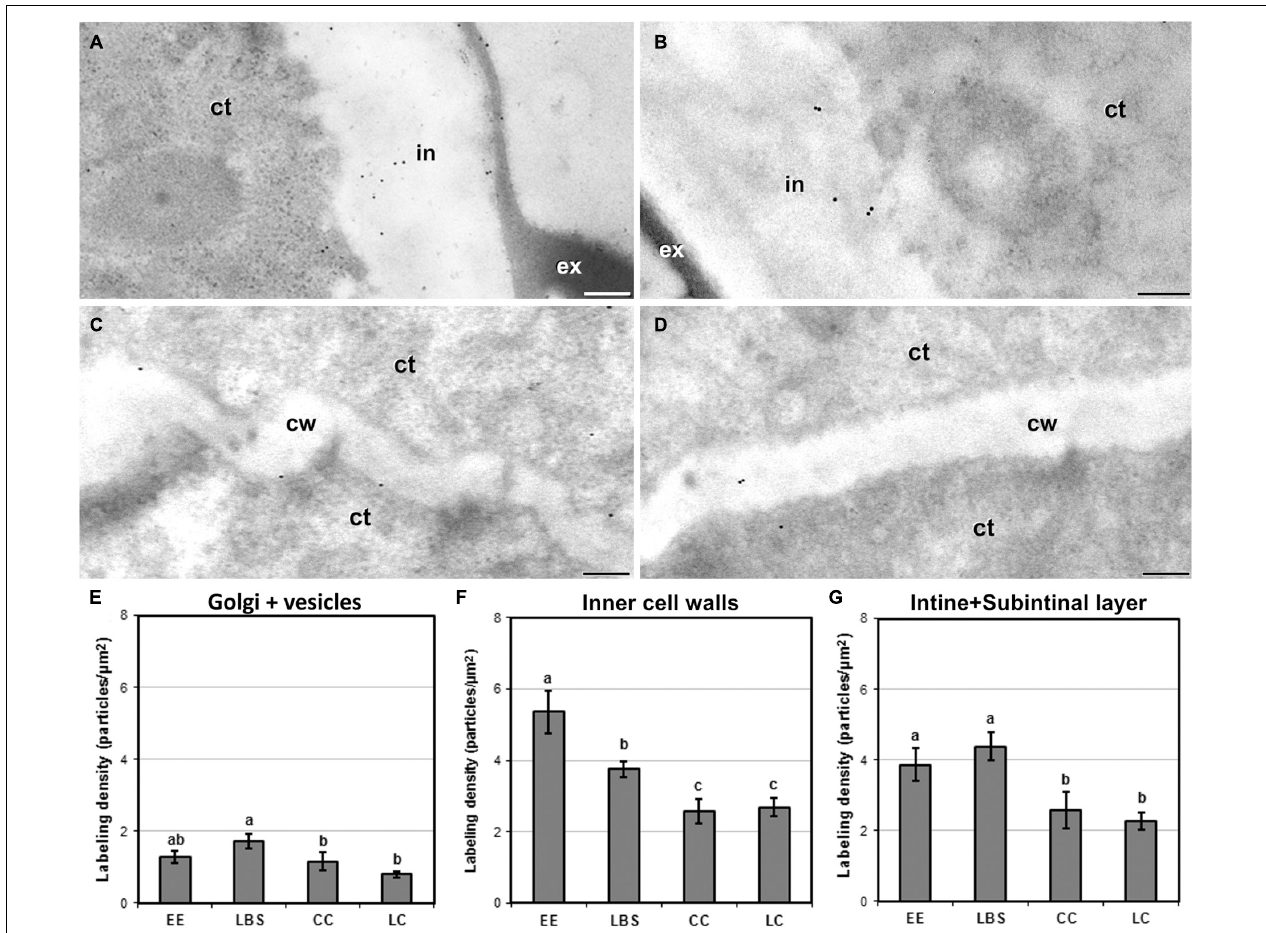
FIGURE 7 | Detection of JIM7-cross-reacting highly methyl-esterified pectin by immunogold labeling and quantification in TEM images of 5-day-old microspore cultures. External cell wall images of EE (A) and CC (B) . Inner cell wall images of EE (C) and CC (D) . (E) Quantification of JIM7-cross-reacting highly methyl-esterified pectin in cytoplasmic Golgi stacks and vesicles. (F) Quantification of JIM7-cross-reacting highly methyl-esterified pectin in inner cell walls. (G) Quantification of JIM7-cross-reacting highly methyl-esterified pectin in outer cell walls (intine + subintinal layer). Labeling density is expressed in number of particles per µ m 2 . Different letters represent statistically significant differences according to LSD test. ct, cytoplasm; cw, cell wall; ex, exine; in, intine; m, mitochondria. Bars: 200